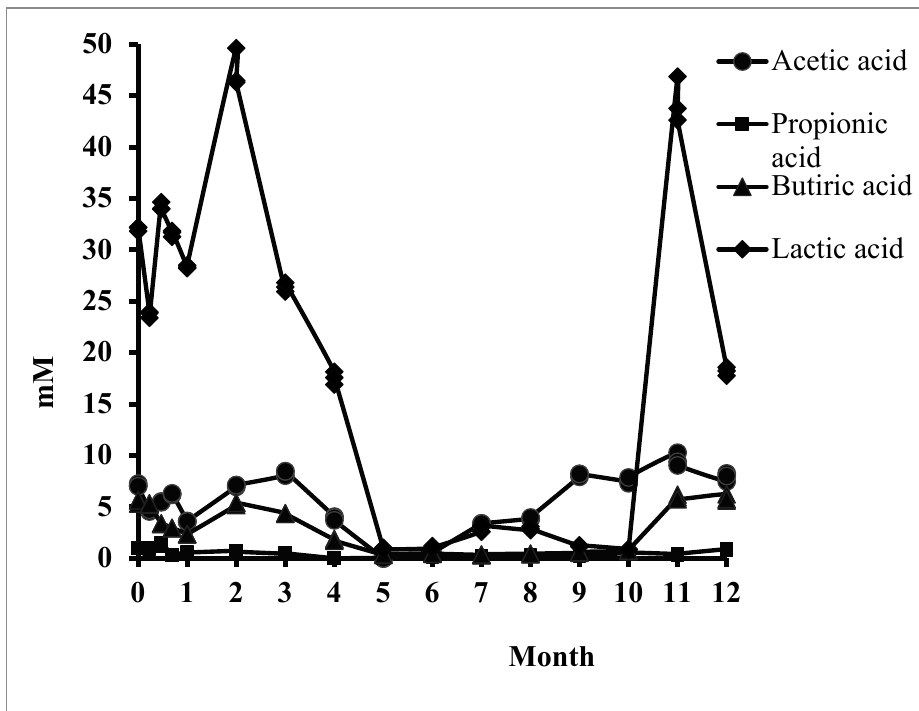
Figure 2. The amount of acetic, propionic, butyric, and lactic acids after in vitro long-term stevio- side consumption.